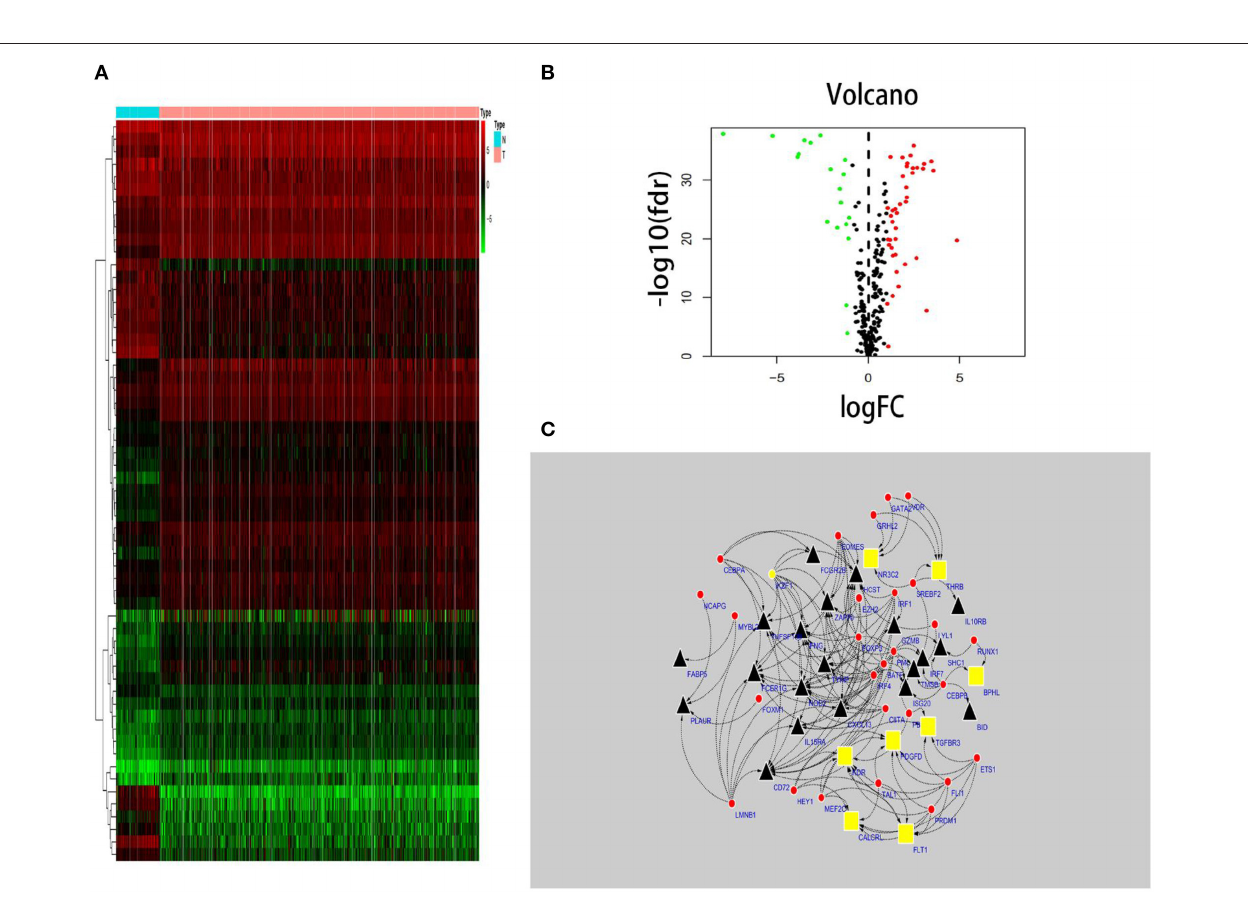
FIGURE 2 | TF-based regulatory network. Construction of a TF-based regulatory network. (A) A heatmap of TFs differentially expressed in the tissue samples. (B) A volcano plot of differentially expressed TFs. (C) A regulatory network constructed from potentially relevant TFs (red), low-risk IRGs (red), and high-risk IRGs (black). IRGs, immune-related genes; TFs, transcription